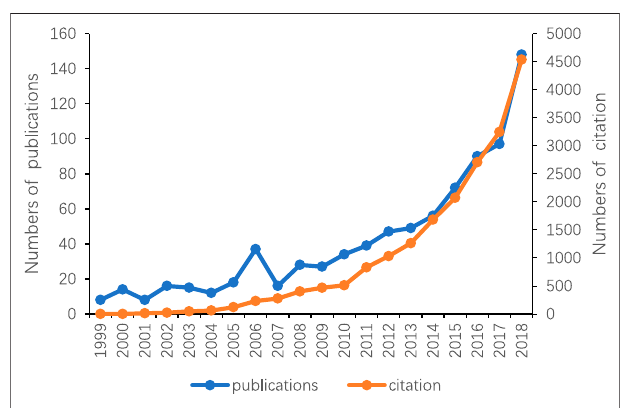
FIGURE 1 | Numbers of publications and citations in electricity demand forecasting, 1999 – 2018.